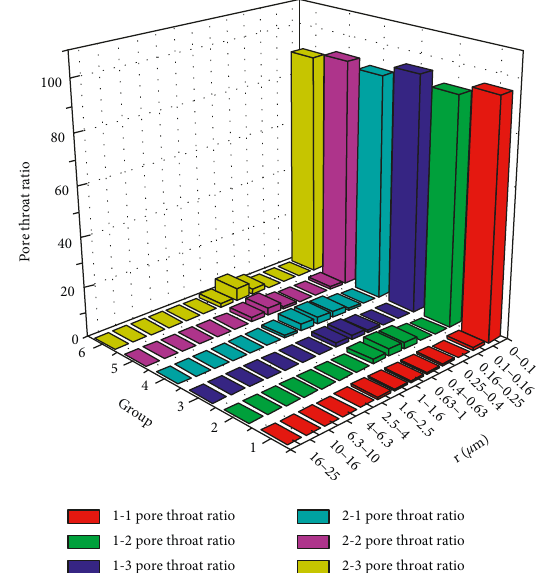
Figure 2: Distribution of pore throats in coal